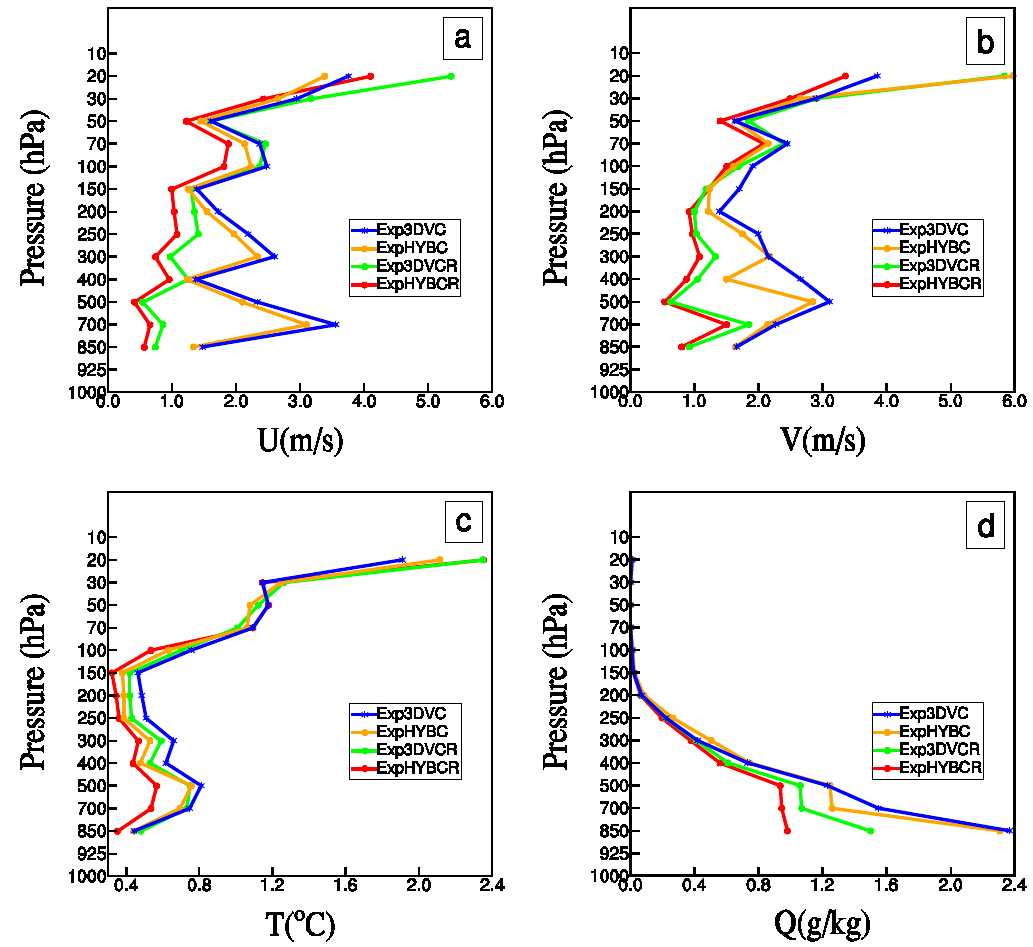
Figure 14. Vertical -profile of average RMSEs of forecast background against all the radiosondes in the 3-km domain for: ( a ) u component (unit: m s −1 ); ( b ) v component (unit: m s −1 ); ( c ) T (unit: °C); and ( d ) Q (unit: g kg −1 ), from Exp3DVC (blue curve), ExpHYBC (orange curve), Exp3DVCR (green curve) and ExpHYBCR (red curve).